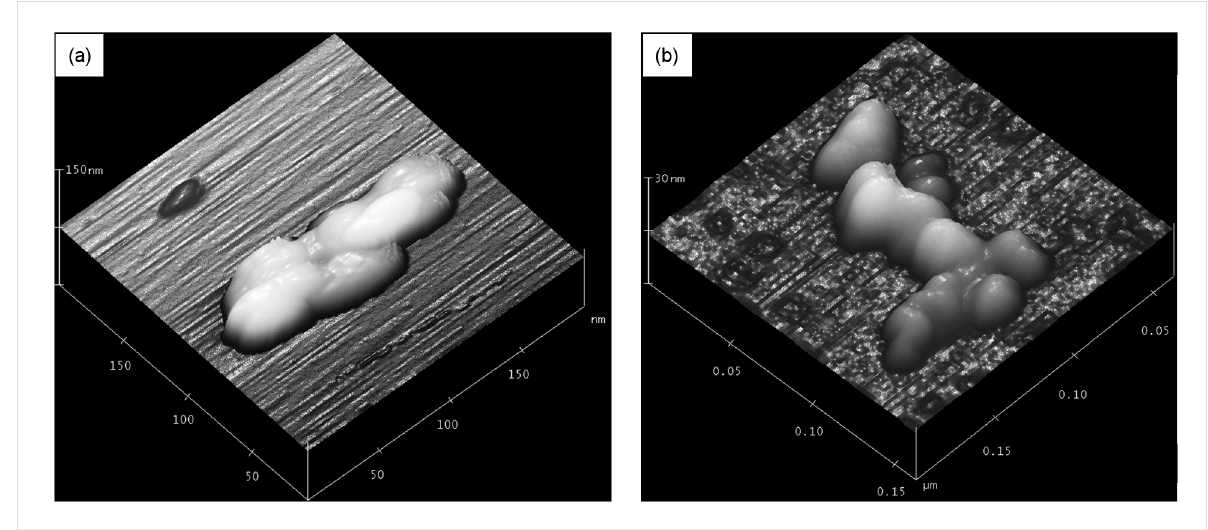
Figure 1: AFM images of (a) Fe-Ni/Zn and (b) Fe-Ni/Zn/ β